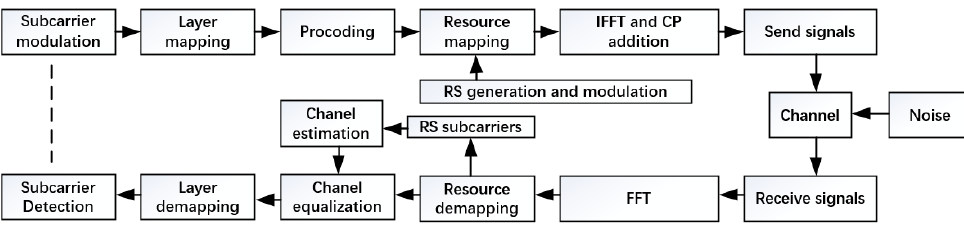
Figure 1. The flow chart of the 5G baseband